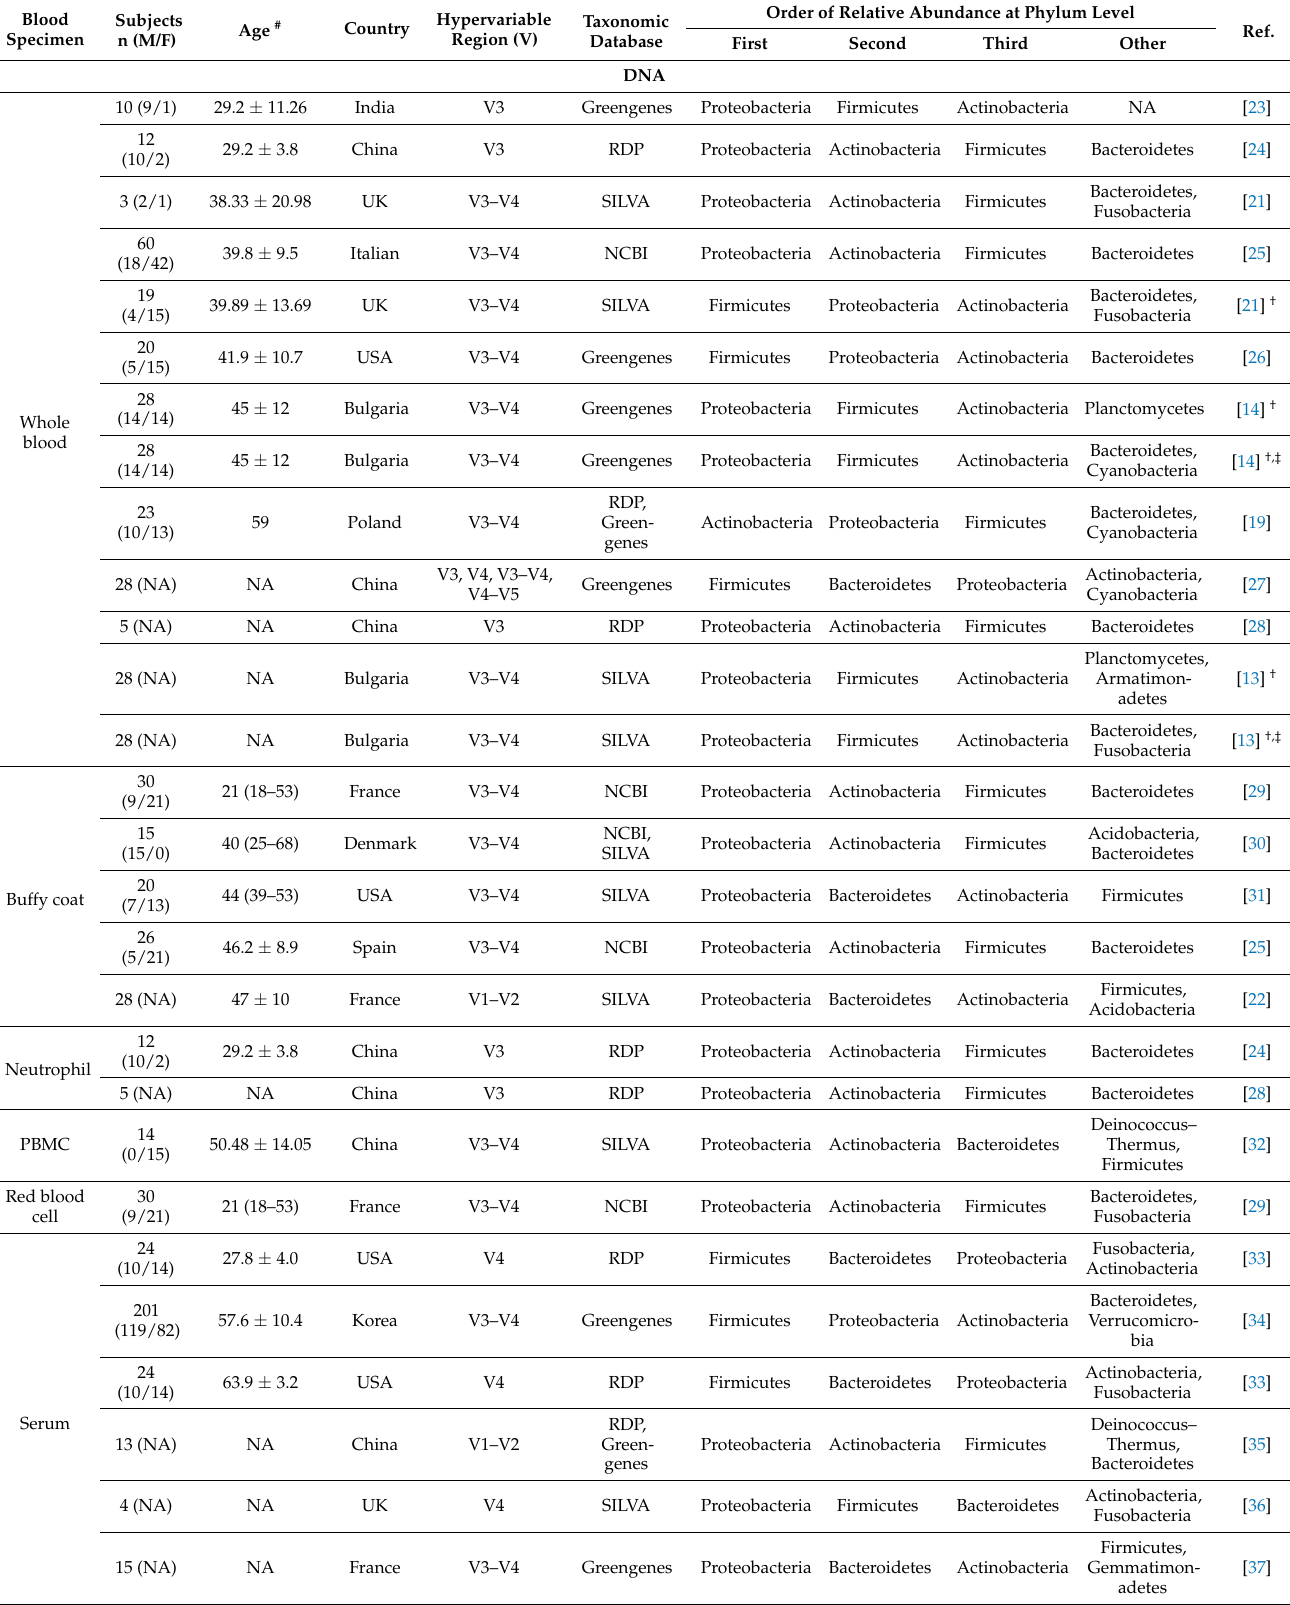
Table 1. Eubiotic Characteristics of the Blood Bacteriome in Healthy